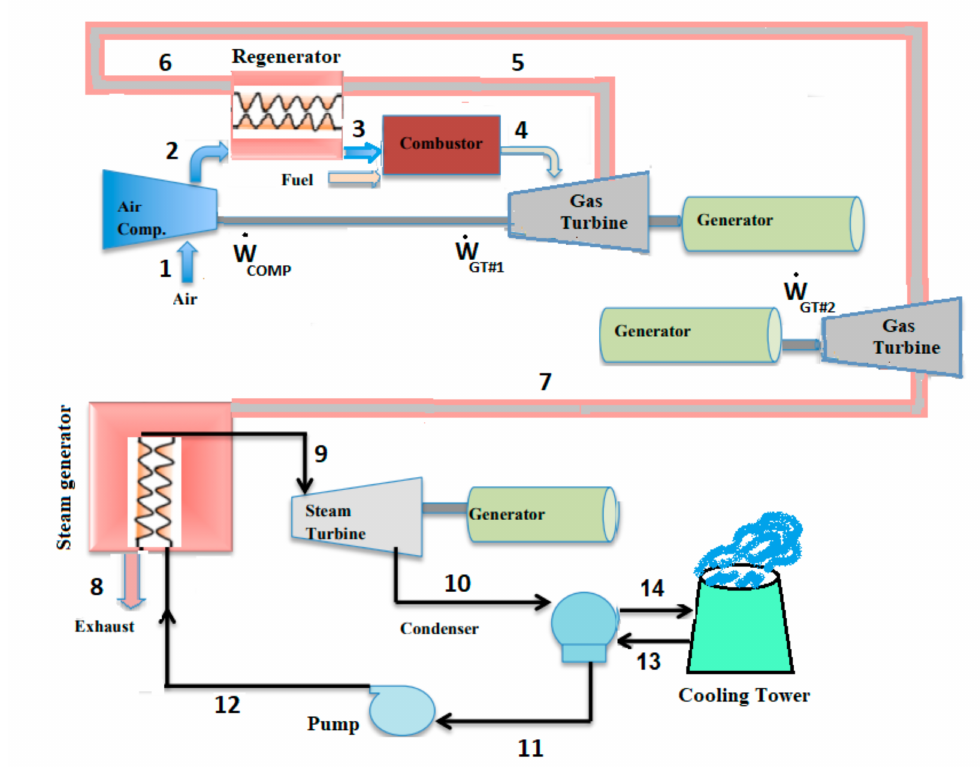
Figure 3. Schematic of the new combined regenerative Brayton and Rankine cycle (Config.